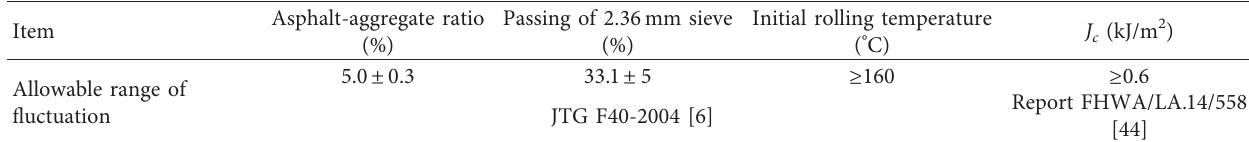
Table 19: Allowable ranges of fluctuation of key construction